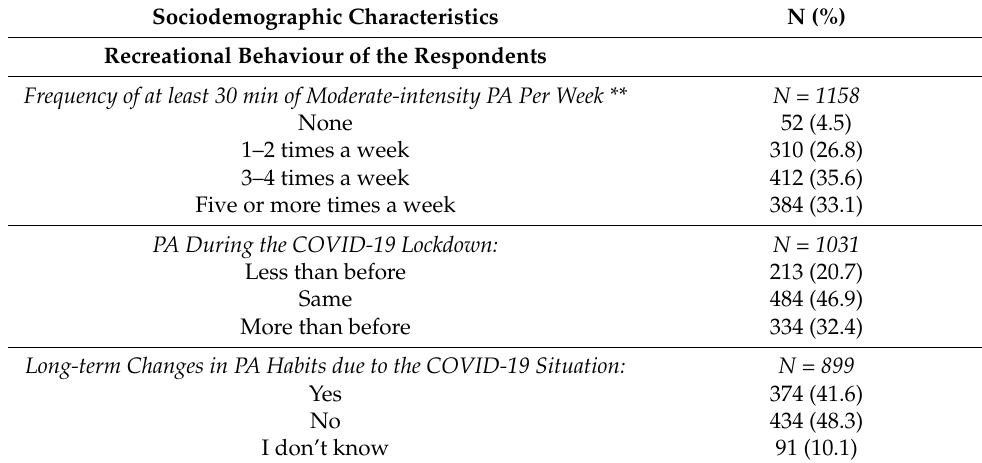
Table 1. Cont . Sociodemographic Characteristics Recreational Behaviour of the Respondents